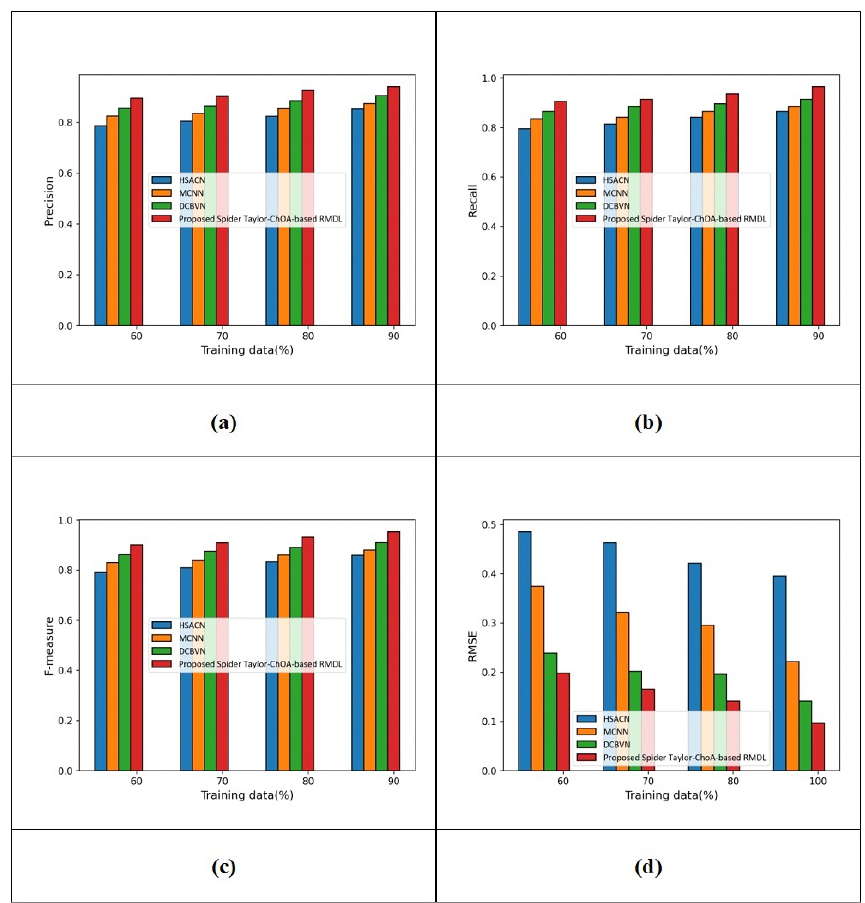
Figure 4. Results based on sentiment classification using IMDB datasets with ( a ) precision ( b ) recall ( c ) F-measure and ( d )